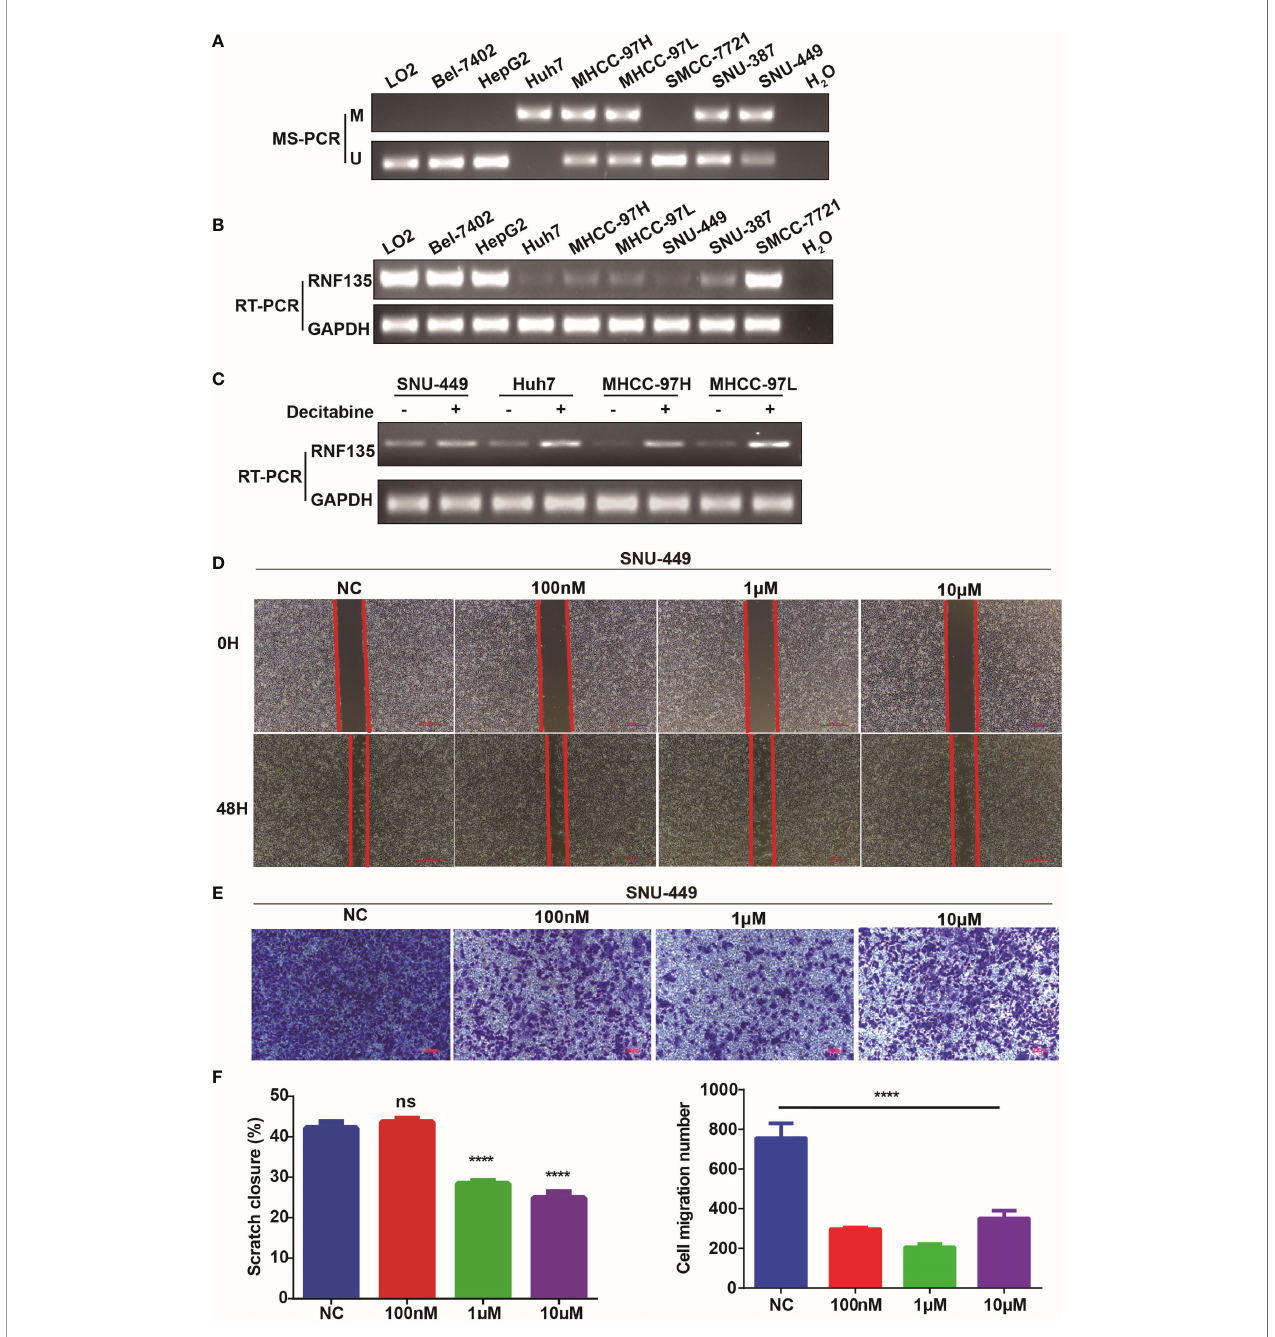
FIGURE 2 | Correlation between RNF135 methylation and mRNA expression in HCC cell lines. (A) The methylation status in immortalized normal liver cell line LO2 and HCC cell lines (Bel-7402, HepG2, Huh7, MHCC-97H, MHCC-97L, SMMC-7721, SNU-387, and SNU-449) were measured by MS-PCR (M, methylation; U, unmethylation). H 2 O was used as a negative control. (B) The expression levels in cell lines were determined by semi-quantitative RT-PCR, and